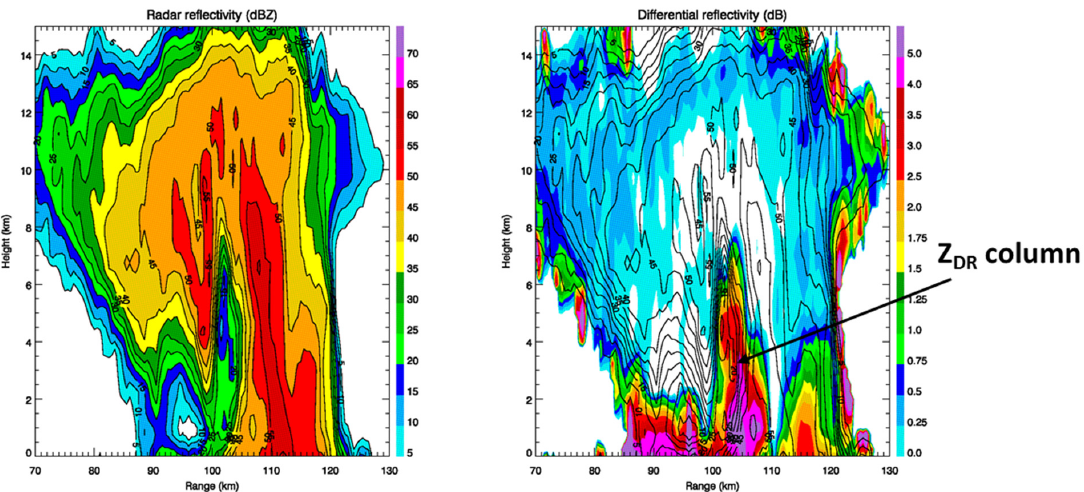
Figure 2. Composite Range-Height Indicator (RHI) of Z and Z DR measured in a tornadic storm in Oklahoma on 29 May 2004. Overlaid are Z contours drawn every 5 dBZ.